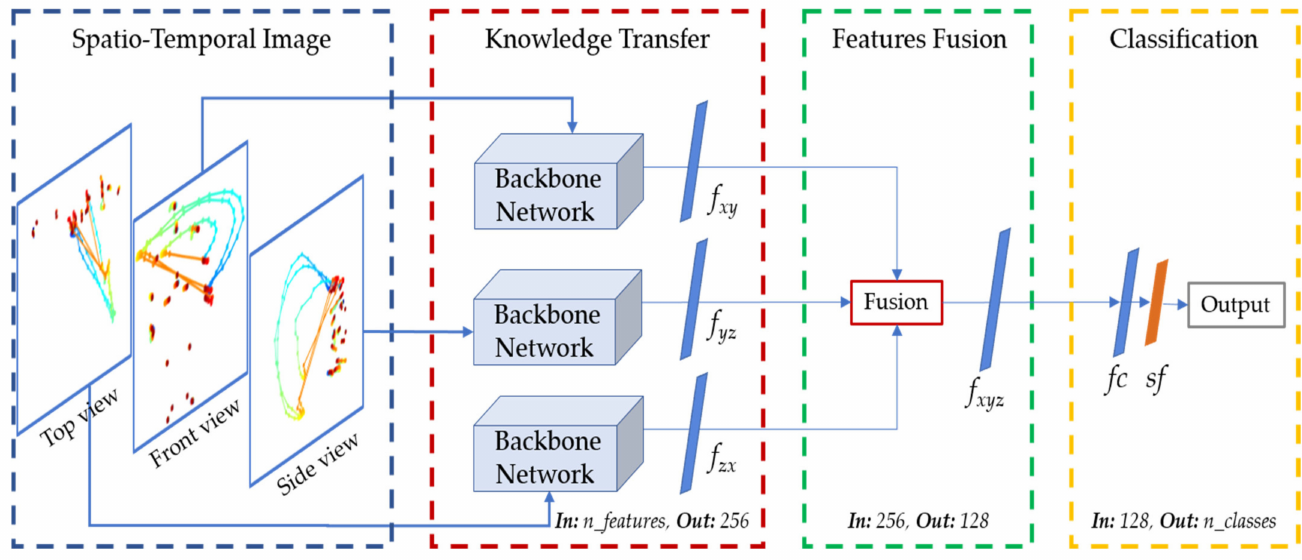
Figure 5. Architecture of the proposed